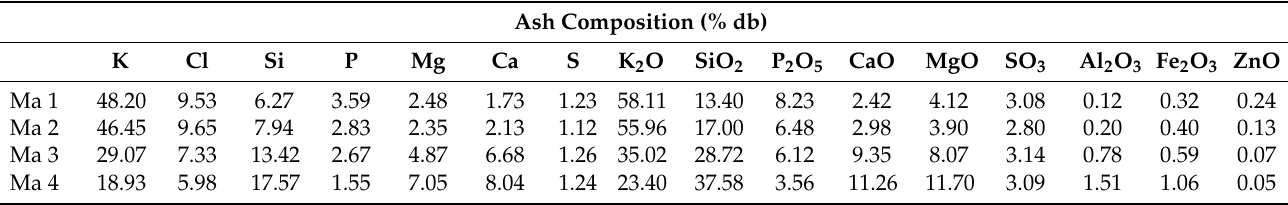
Table 2. Ash composition after